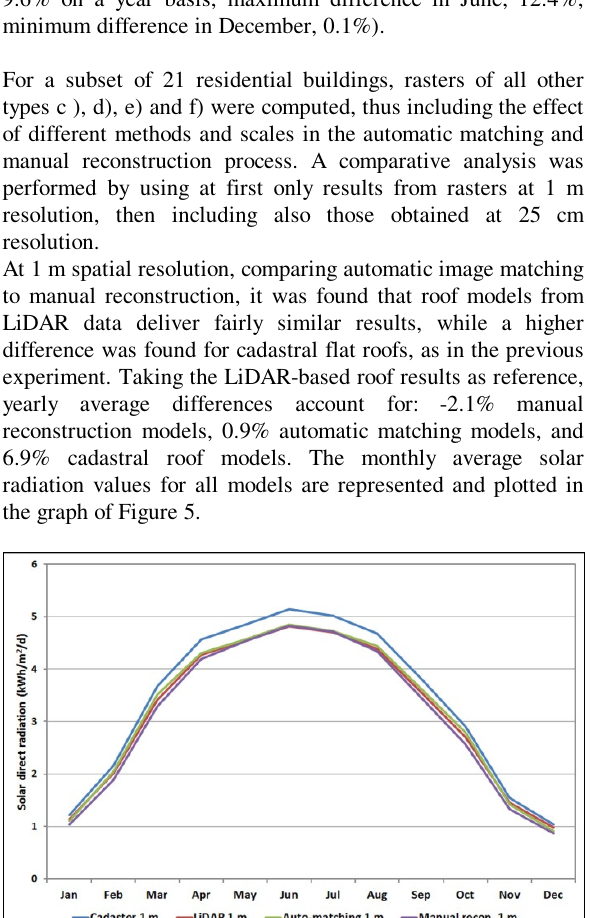
Figure 6 – Comparison between solar radiation results obtained from all rasters, at 1 m and 25 cm resolution. Data at 1 m resolution are the same as in Figure 5.